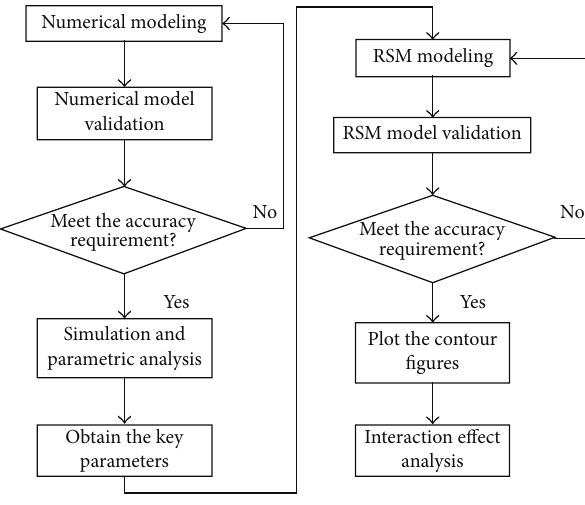
Figure 2: Research